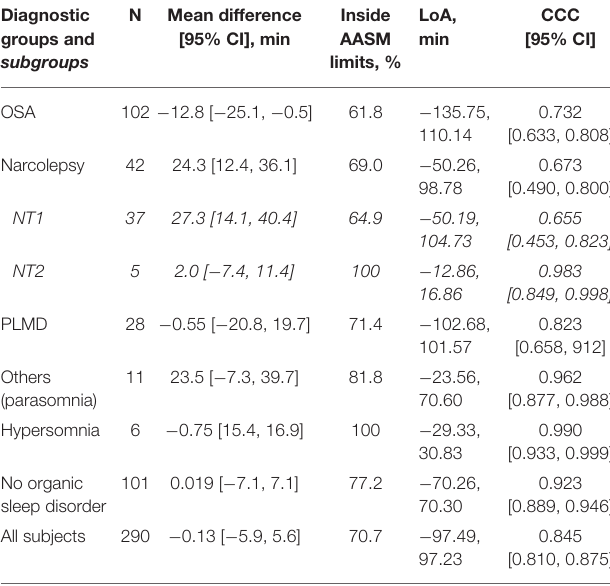
TABLE 2 | Concordance of sleep time between actigraphy and ambulatory polysomnography. Diagnostic groups and